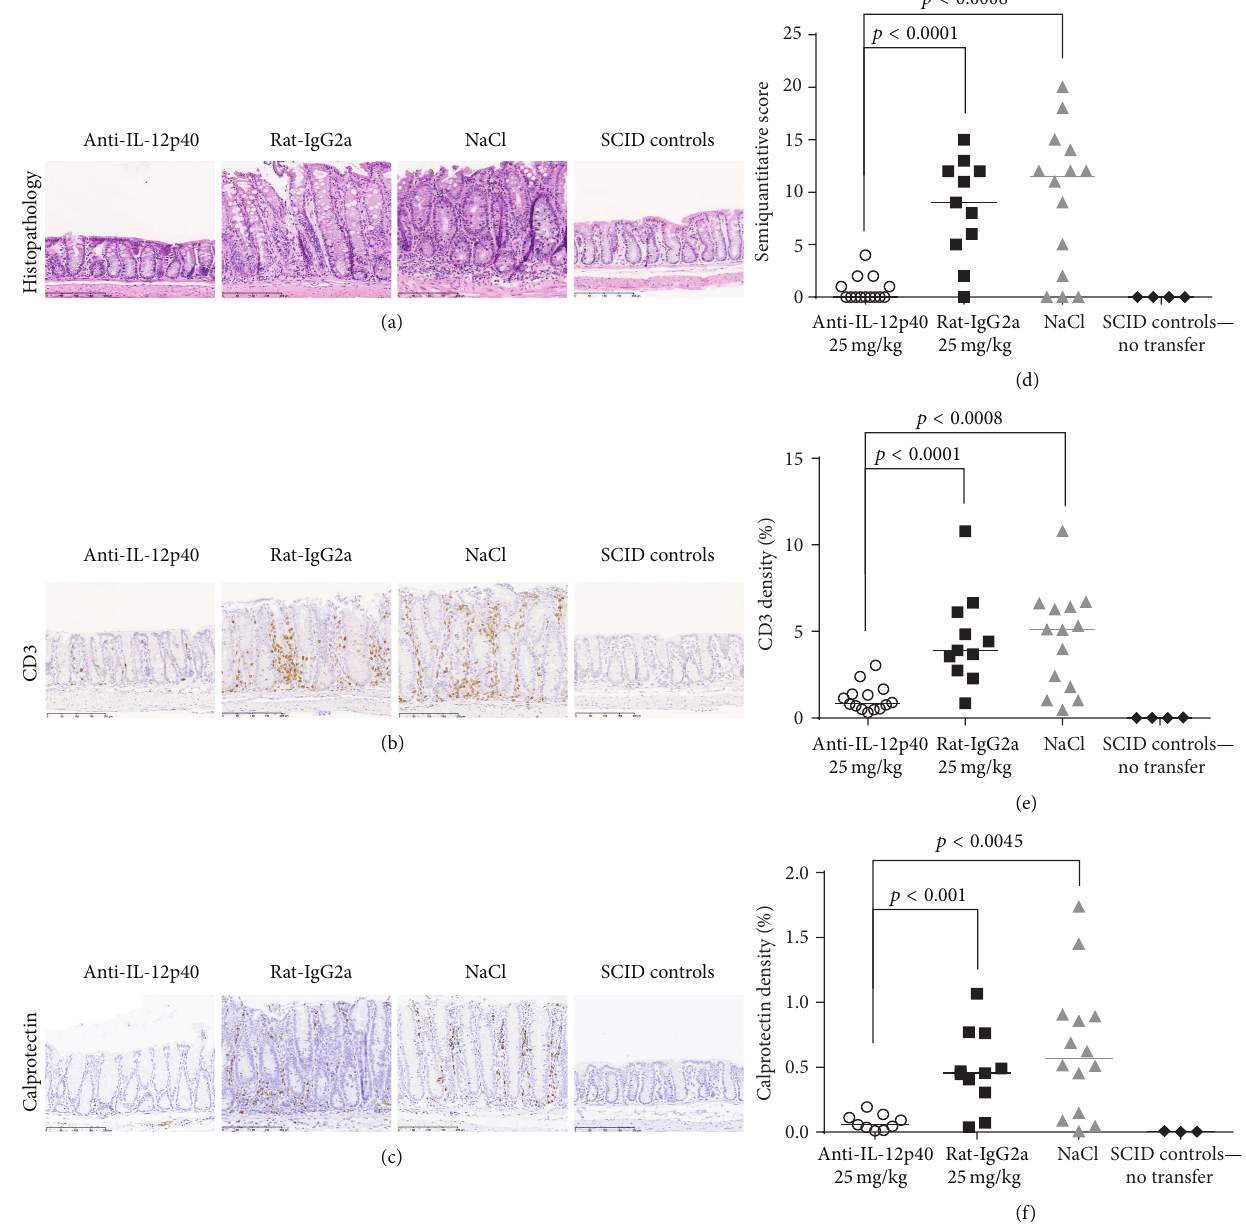
Figure2:Histologyandimmunohistochemistryofrepresentativeareasofmousecolon.Theleftpanel(a,b,c)showsthehistopathologicaland IHC evaluation of the colon. After H&E staining (a), the 12p40-mAb treated mice had normal morphology as seen in the SCID control mice. Rat-IgG2a and NaCl treated mice had major hyperplasia of the mucosal layer and infiltration of immune cells. The CD3 (b) and calprotectin (c) IHC identify these immune cells as being CD3 or calprotectin positive cells as visualized with the brown DAB staining of the positive cells in the mucosa layer and submucosa. The scale bar indicates 200 𝜇 m and all images are captured at 20x magnification. The images are from the mouse with the results representing the group median for the specific staining of the four mice groups. The right panel (d, e, f) depicts the results from the histopathological (d) evaluation using a semiquantitative score (range 0–24). CD3 (e) and calprotectin (f) staining were quantitatively assessed by digital image analysis; data is represented as the density of the IHC reactivity (%).